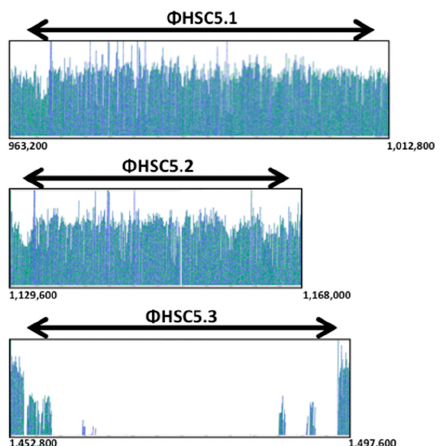
Figure 2. Whole genome sequencing revealed the deletion of Φ HSC5.3 in spontaneous capsule thermoregulation ‐ negative mutants. The chromosomes of spontaneous capsule thermoregulation mutants were sequenced and compared to that of the wild ‐ type HSC5. Each vertical line in the boxed figures is a pile ‐ up of DNA sequences from Illumina next generation sequencing and indicates the presence of the sequence on the chromosome. The numbers under the boxed figures represent the location on the chromosome. Each horizontal arrow on top of the boxed figures indicates the position of each prophage on the chromosome: 964214–1010974 for Φ HSC5.1, 1130407–1166414 for Φ HSC5.2, and 1454753–1496038 for Φ HSC5.3. Even though Φ HSC5.3 was cured in the mutants, some sequences in Φ HSC5.3 appeared due to the existence of homologous genes in the prophages Φ HSC5.1 and Φ HSC5.2.